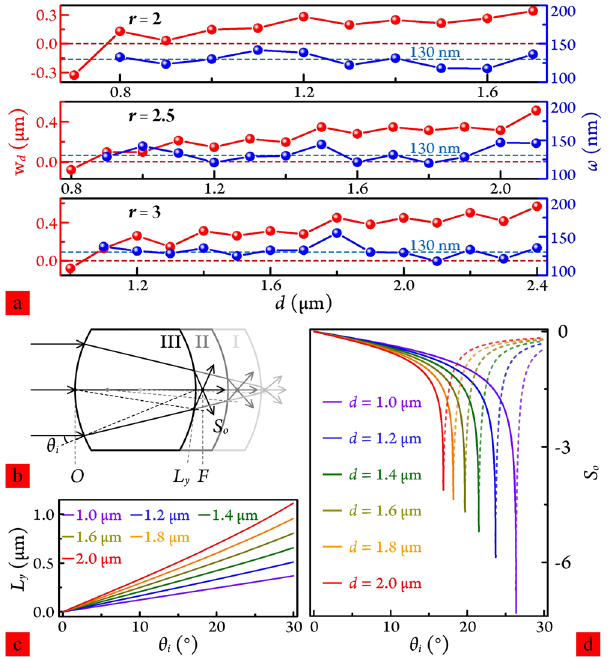
Figure 3. ( a ) Working distance W d and FWHM beam width, ω of PNJs for r = 2, 2.5 and 3 μ m as a function of reducing length d . ( b ) Ray tracing analysis for plane-wave-illuminated R-MPCM for the three cases of ( a ). ( c ) Emitting point locations, and ( d ) emergent ray slopes for r = 2.5 μ m and length reduction from d = 1.0 to 2.0 μ m,